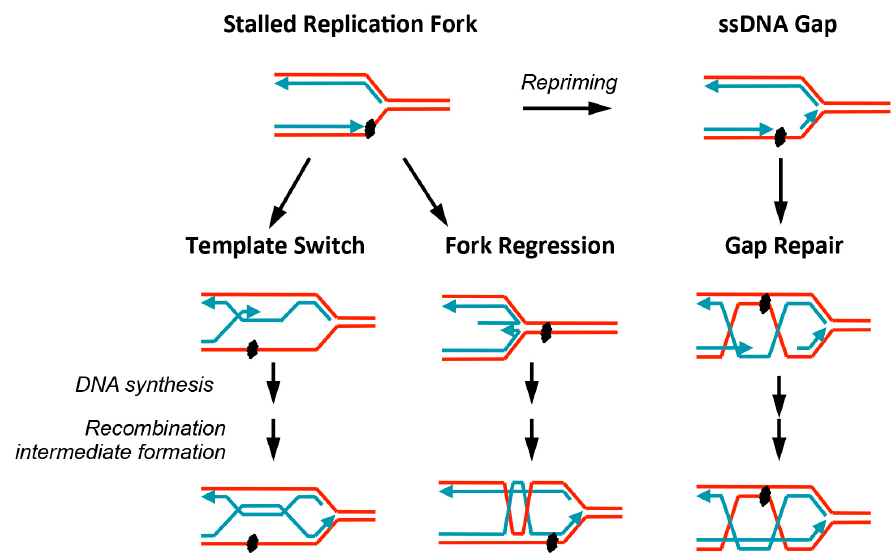
Figure 2. Replication-associated recombinational repair processes. Upon encountering DNA template lesions, replication forks stall and can be repaired by multiple modes of recombinational repair. The template switch pathway (left) uses the homologous sequence on the sister chromatid as a template to replicate over the damaged region. The fork regression pathway (middle) entails the dissociation of nascent strands from their templates and their annealing with each other. One of the nascent strands can utilize the other as a template for limited DNA synthesis and/or invade the homologous template strand, forming recombination intermediates. In other situations, replication may resume downstream of a template lesion, leaving behind an ssDNA gap (right). Such a gap can be filled through recombination using the sister chromatid as a template. All three situations depicted generate DNA intermediates in the form of joint molecules, which must be processed through dissolution or resolution. It is of note that only one possible model for each situation is shown here, though others are also feasible.